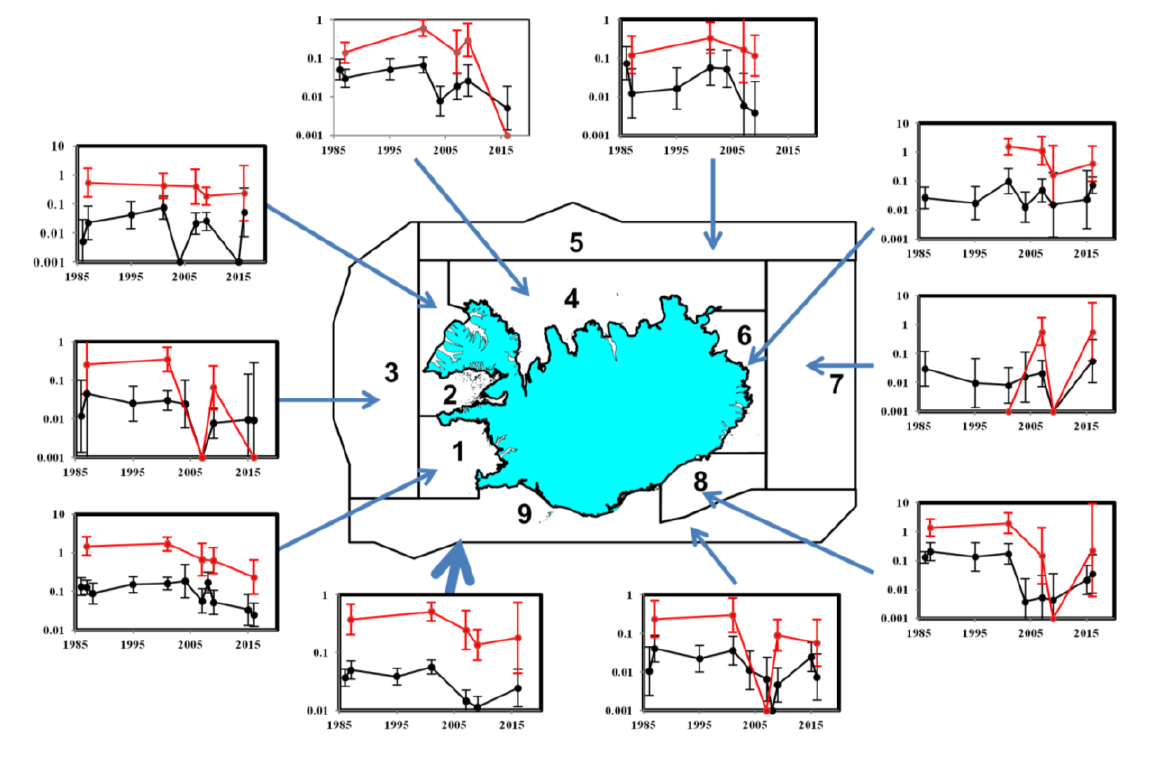
Figure 11. Trends in the relative abundance (black line, uncorrected line transect density, whales nm -2 ) and fully corrected density (red line) of common minke whales by stratum and for the entire survey area (thick arrow). Zero values of density are shown as the lowest value on the Y-axis. 95% confidence intervals are